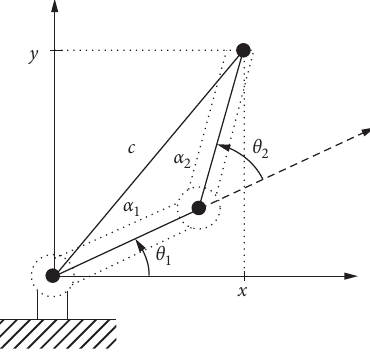
Figure 8: Inverse geometric modelling.